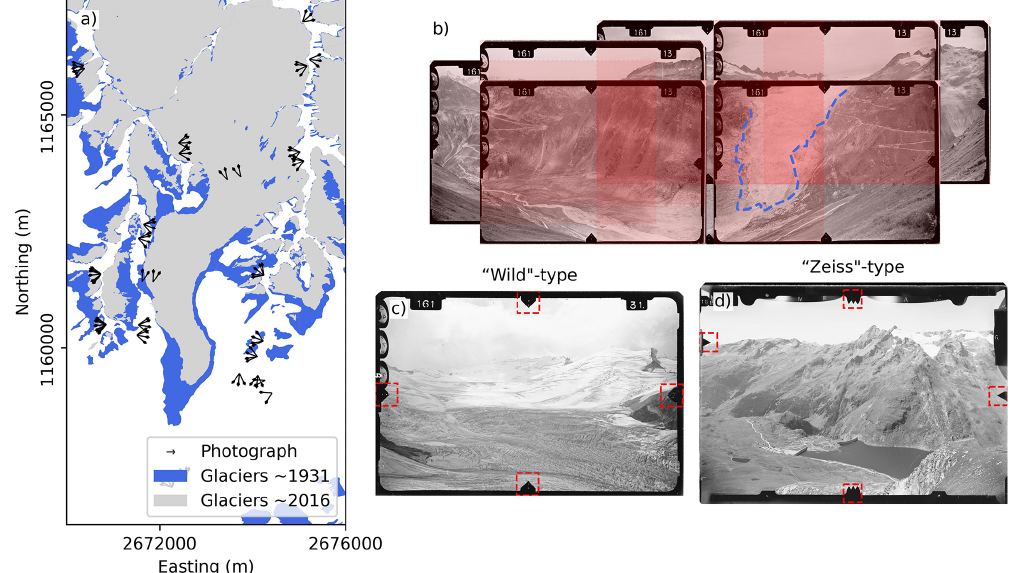
Figure 2. (a) Imaging locations (black arrows pointing in the imaging direction) together with ca. 1931 (blue) and ca. 2016 (grey) glacier outlines for Rhonegletscher (alternatively Rhône Glacier). (b) Panorama example overlooking Rhonegletscher (outlined in dashed blue). The transparent red boxes show the coverage of each image. The darkest red indicates five images overlapping. (c, d) Examples of a “Wild”- type (c) and a “Zeiss”-type (d) photograph and associated fiducial marks (framed in red).